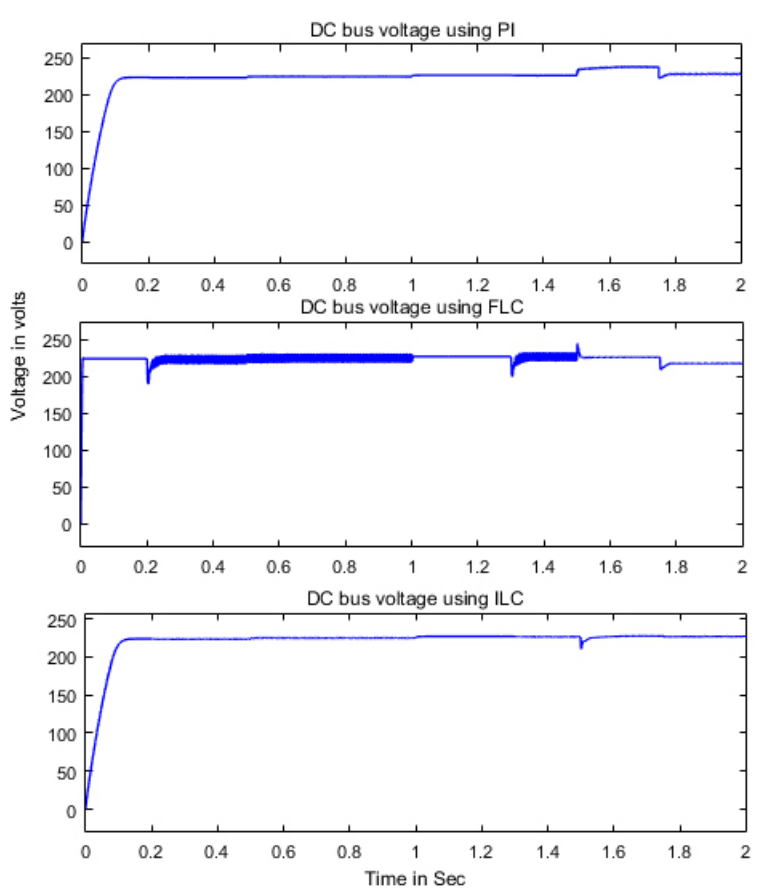
Figure 28. Comparison of DC bus voltage using various